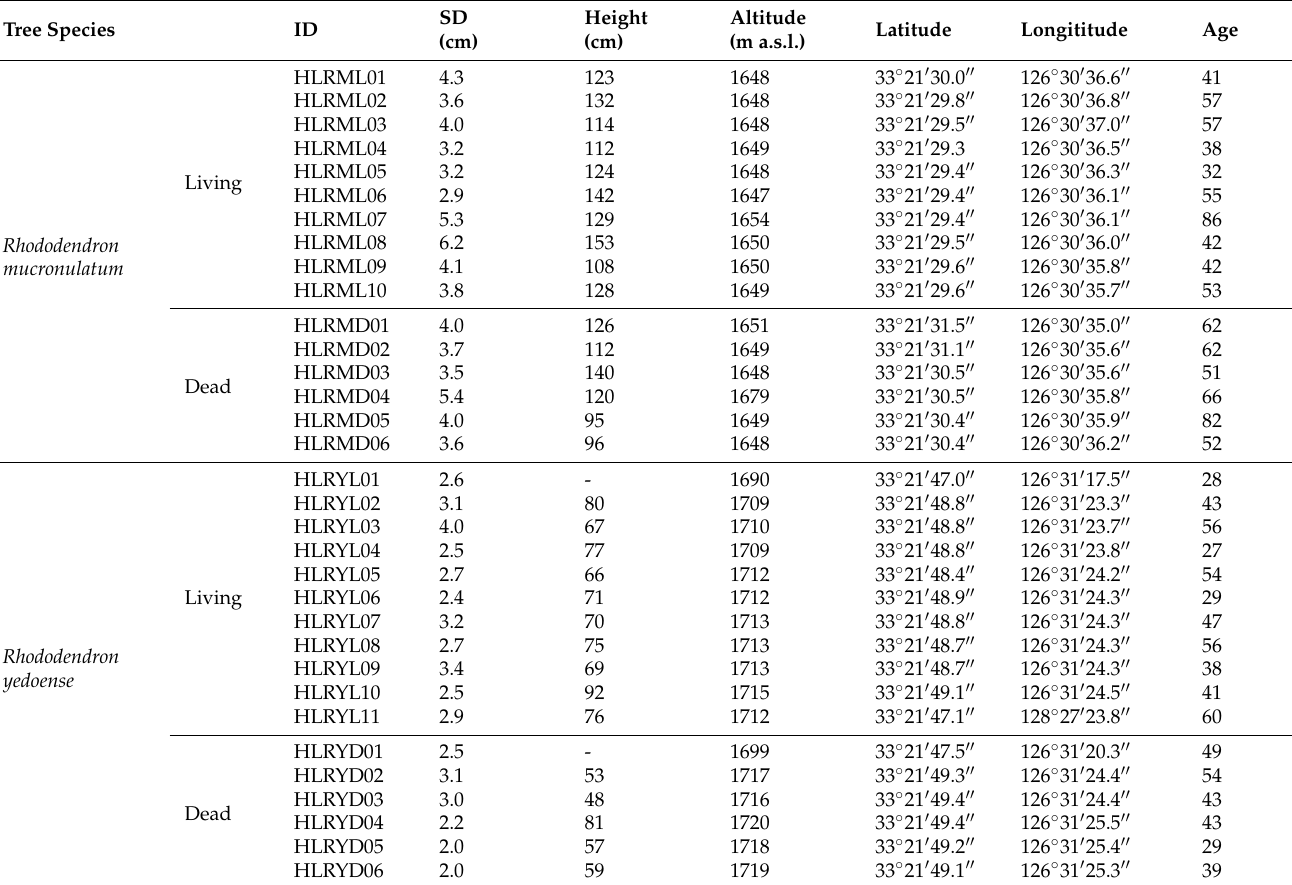
Table 1. Description of the experimental